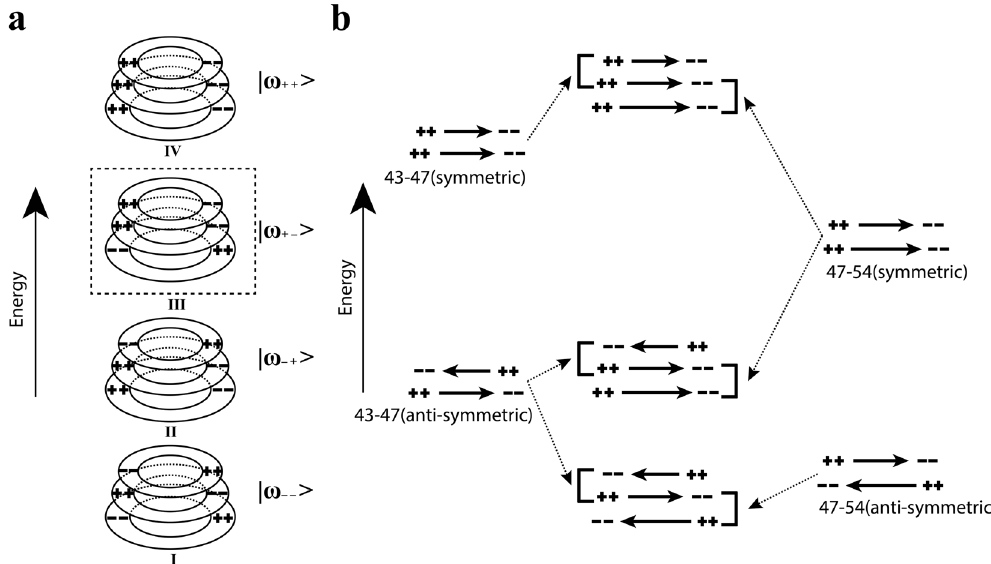
Figure 7. ( a ) Hybridized modes of three stacked rings. ( b ) Each mode consists of two sub-hybridized modes. Each of the hybridized modes is labelled based on which of the two rings (of radius 43, 47 and 54 μ m) are